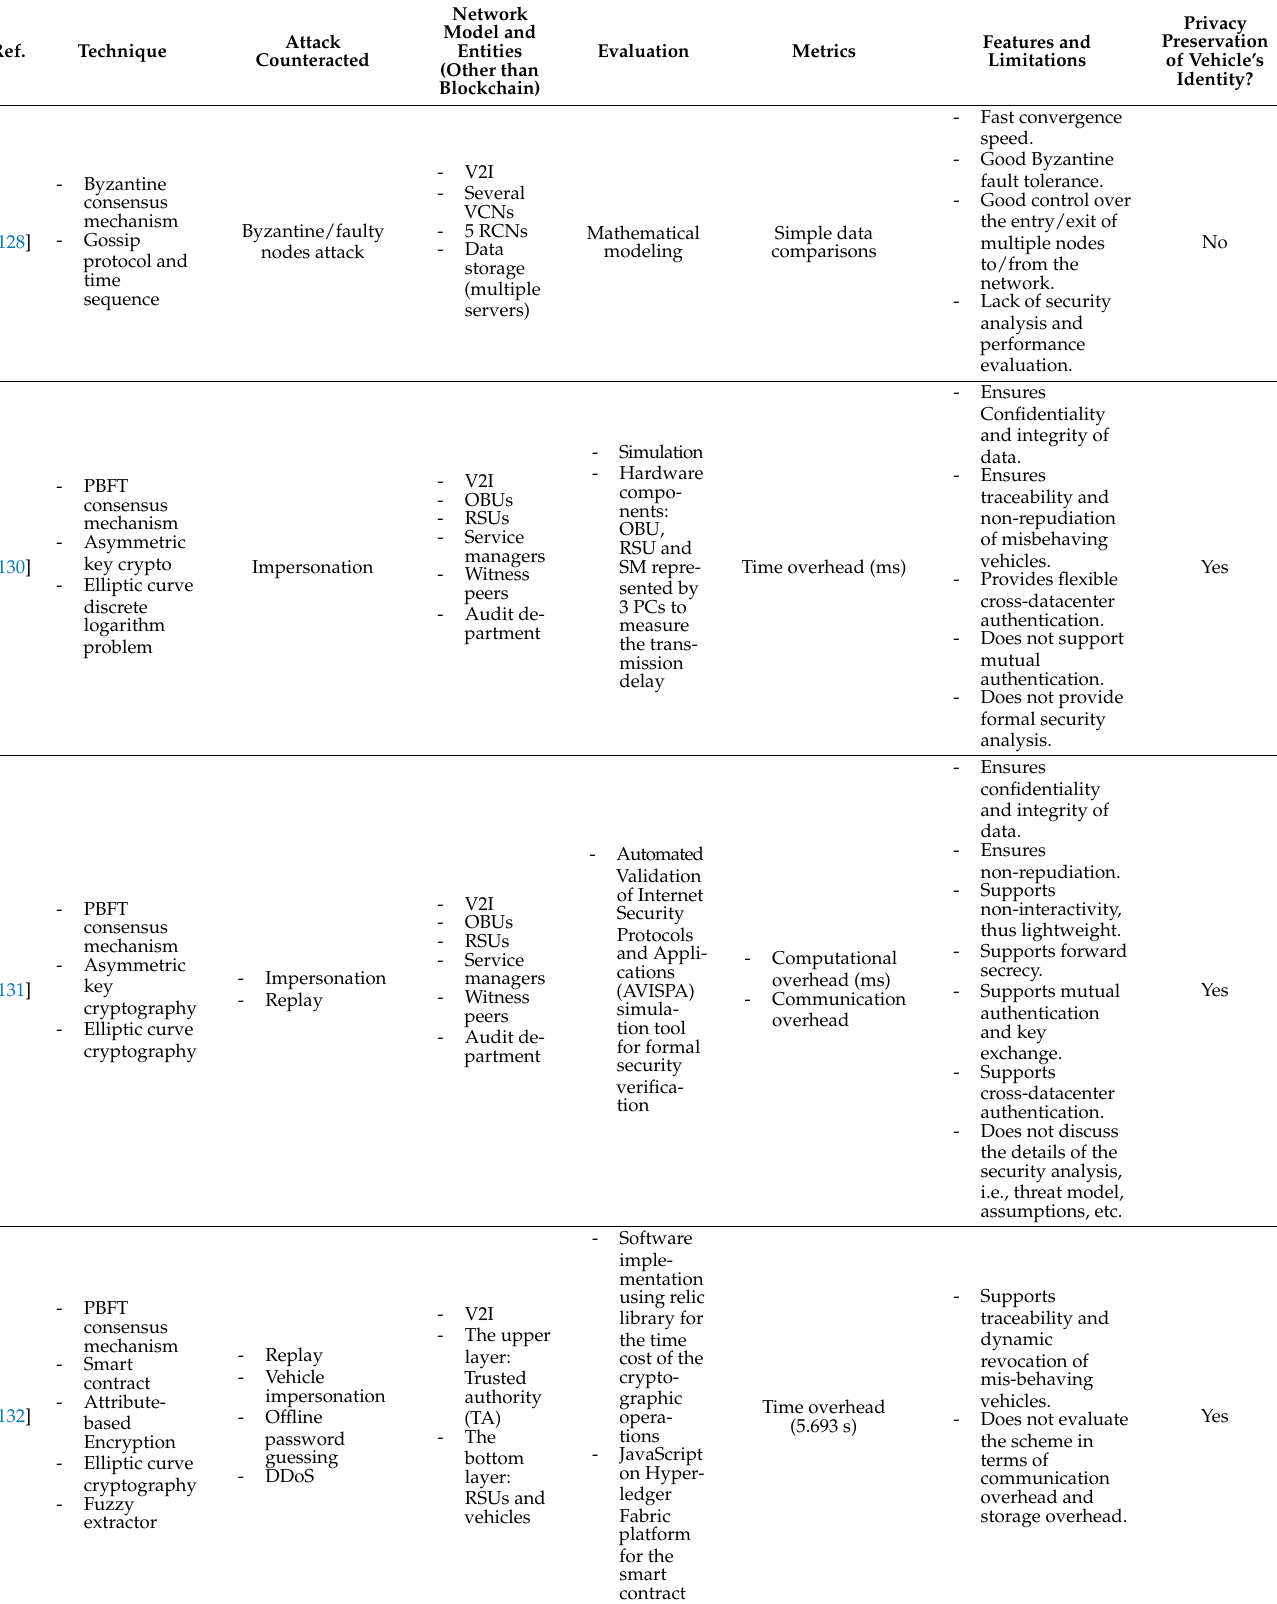
Table 6. A comparative study of the consortium blockchain-based authentication schemes in IoV and VANETs.